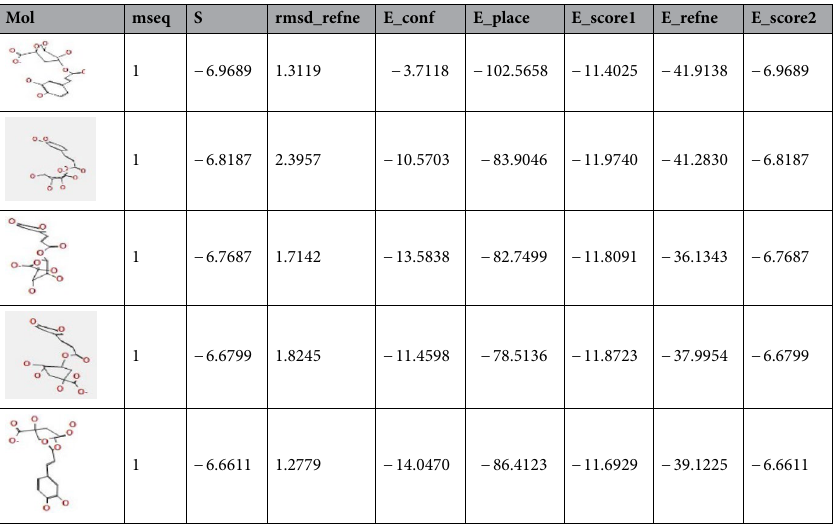
Table 7. Docking score and energies of chlorogenic acid with 6U7H receptors.